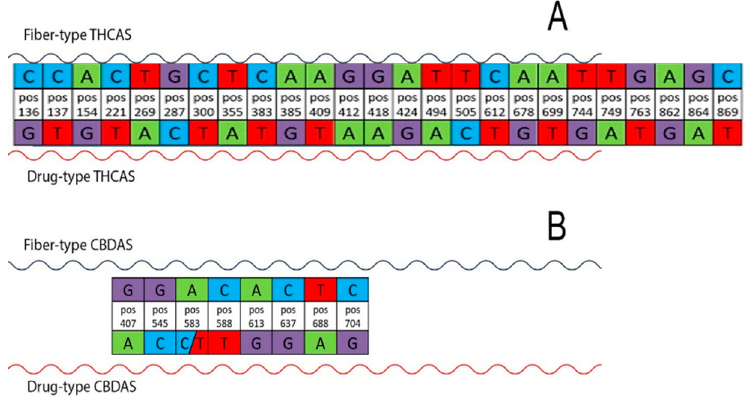
Figure 3. Significant single-nucleotide polymorphisms (SNPs) able to discriminate between the two cannabis subgroups of the di ff erent varieties (drug-type vs. fiber-type) are shown. Twenty-five significant SNPs are highlighted for THCAS ( A ) and eight for CBDAS ( B ). Each base change and its corresponding position (pos) in the gene are indicated.